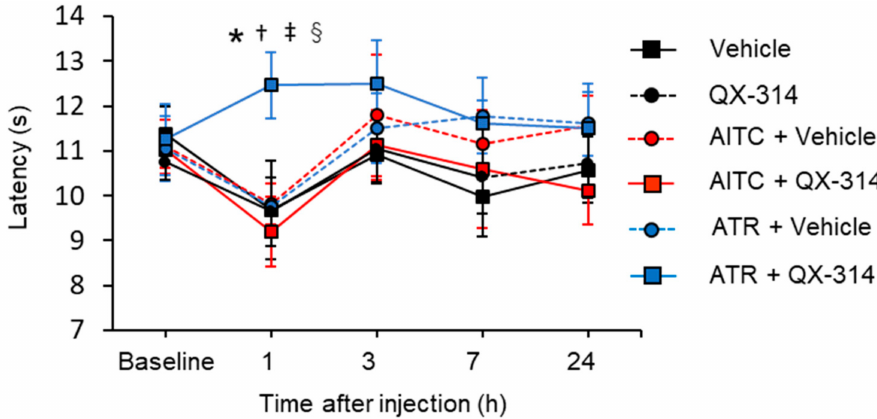
Figure 7. Time course of changing of noxious heat threshold by Hargreaves test after co-application of atractylodin and QX-314 in mice hind paw. Injections in the mice hind paw of different arms were as follows: 20 µ l of vehicle ( n = 6), 2% QX-314 ( n = 6), 5 mM AITC + vehicle ( n = 6), 5 mM AITC + 2% QX-314 ( n = 6), 2 mM ATR + vehicle ( n = 7), and 2 mM ATR + 2% QX-314 ( n = 6). Data represent mean ± standard error of mean, * p < 0.05 (vehicle vs. ATR + QX-314), † p < 0.05 (AITC + QX-314 vs. ATR + QX-314), ‡ p < 0.05 (ATR + vehicle vs. ATR + QX-314), § p < 0.05 (QX-314 vs. ATR + QX-314), and two-way analysis of variance with the Fishers’s LSD post hoc test. AITC: allyl isothiocyanate; ATR: